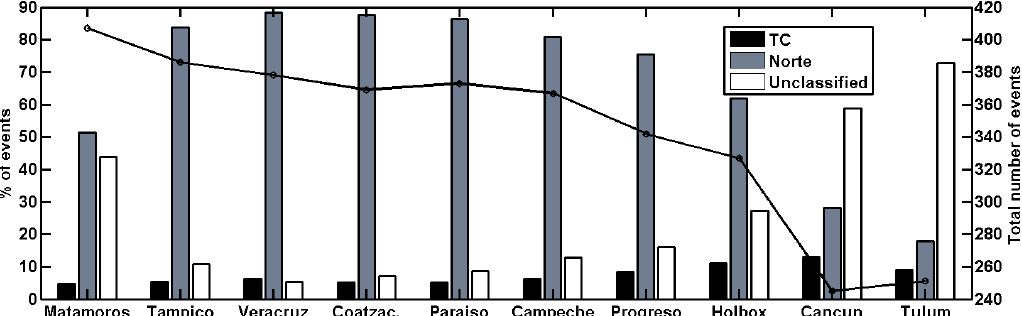
Figure 3. Number of extreme wave events per node (solid line) and their percentage of occurrence according to the considered classification (bars).